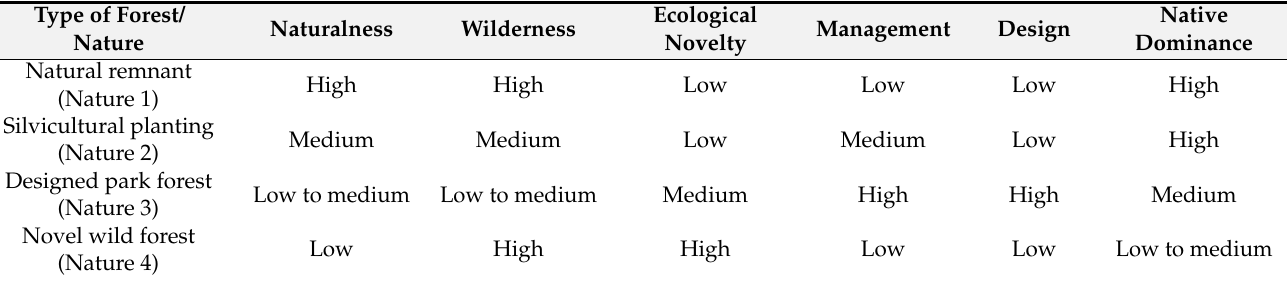
Table 1. Urban forest types, illustrating the four nature types according to Kowarik [42,43], character- ized in relation to gradients of naturalness, wilderness, ecological novelty, management, design and dominance of native trees (see Section 2.1 for further explanation).